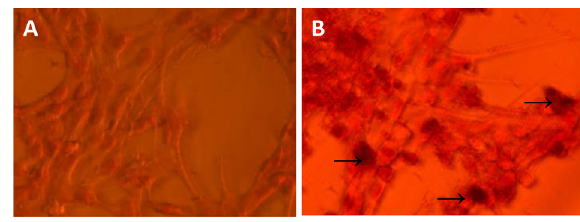
Figure 3. The Investigation of the Effect of HSPPC on the Morphology of MDA-231 Cells Using TUNEL Assay. Control cells (A); The cells under the effect of HSPPC (B); Arrows indicate apoptotic cells; A-B: 200×